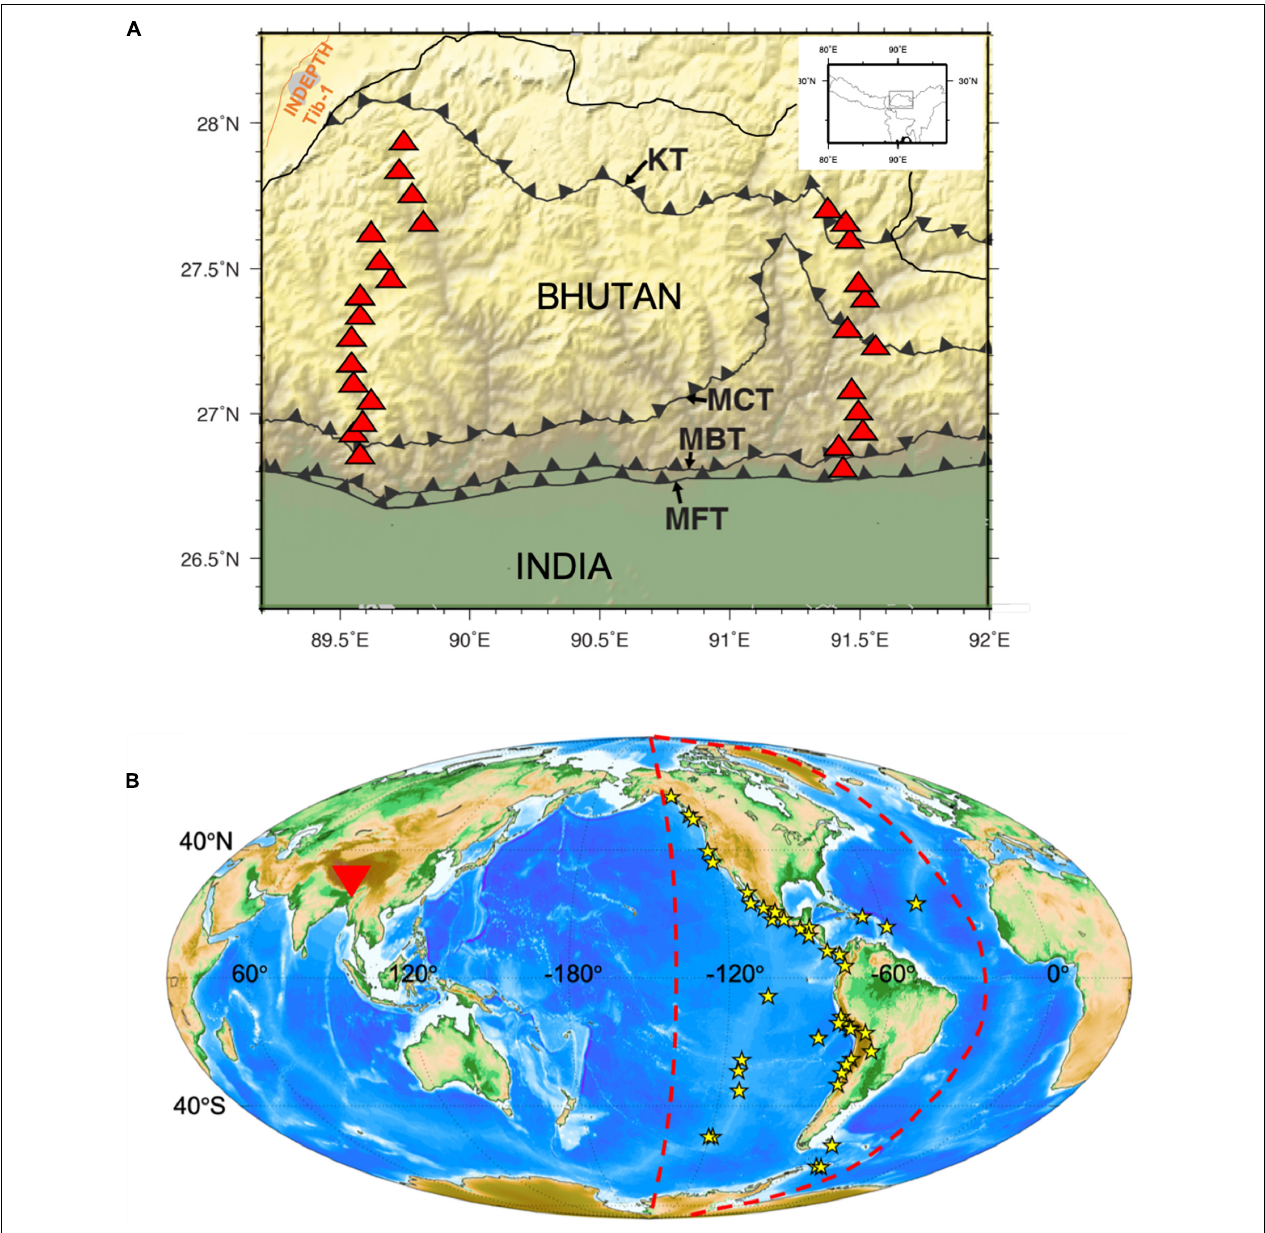
FIGURE 1 | (A) Temporary seismic network stations (red triangles) from the GANSSER project in Bhutan selected for GloPSI application in this study. Main thrust faults are shown on the map: Main Frontal Thrust (MFT), the Main Boundary Thrust (MBT), Main Central Thrust (MCT), and Kakhtang Thrust (KT). The brown line, northwest of Bhutan, indicates the location of the wide-angel reflection profile Tib-1 of the INDEPTH project (e.g., Hauck et al., 1998). (B) Selected earthquakes (yellow stars) at epicentral distances of 120–180 ◦ (red dashed lines) from Bhutan (red triangle) with a sufficiently high signal-to-noise ratio. We found 59 earthquakes with M > 6.0 that satisfy these